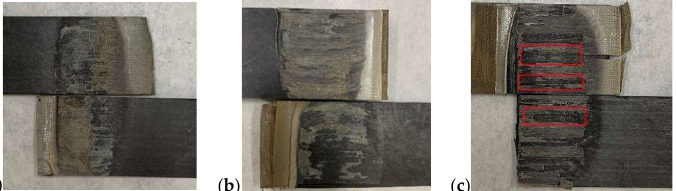
Figure 12. Photos of fracture surfaces of typical welded samples obtained with different heating elements listed in Table 5: ( a ) type A, ( b ) type B, ( c ) type C. Red rectangles indicate the positions of interfacial failure.